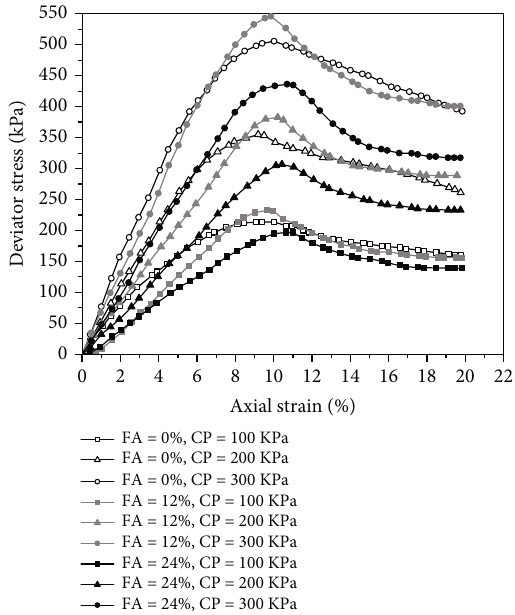
Figure 12: Stress-strain curves ( FT = 30 , L = 12 % ).